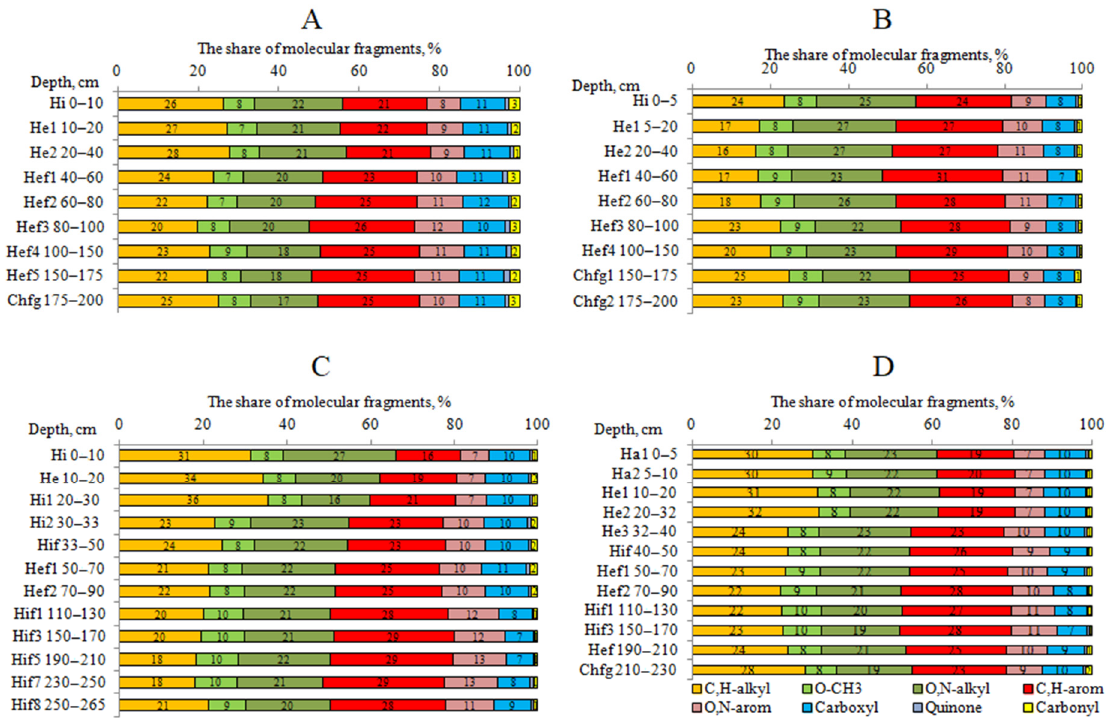
Figure 3. Percentage of carbon in the main structural fragments ( 13 С NMR) of HAs isolated from the Plot 1-1 ( A ), Plot 1-2 ( B ), Plot 2-1 ( C ) and Plot 2-2 ( D ). Plot 1-1 ( A ), Plot 1-2 ( B ), Plot 2-1 ( C ) and Plot 2-2 ( D